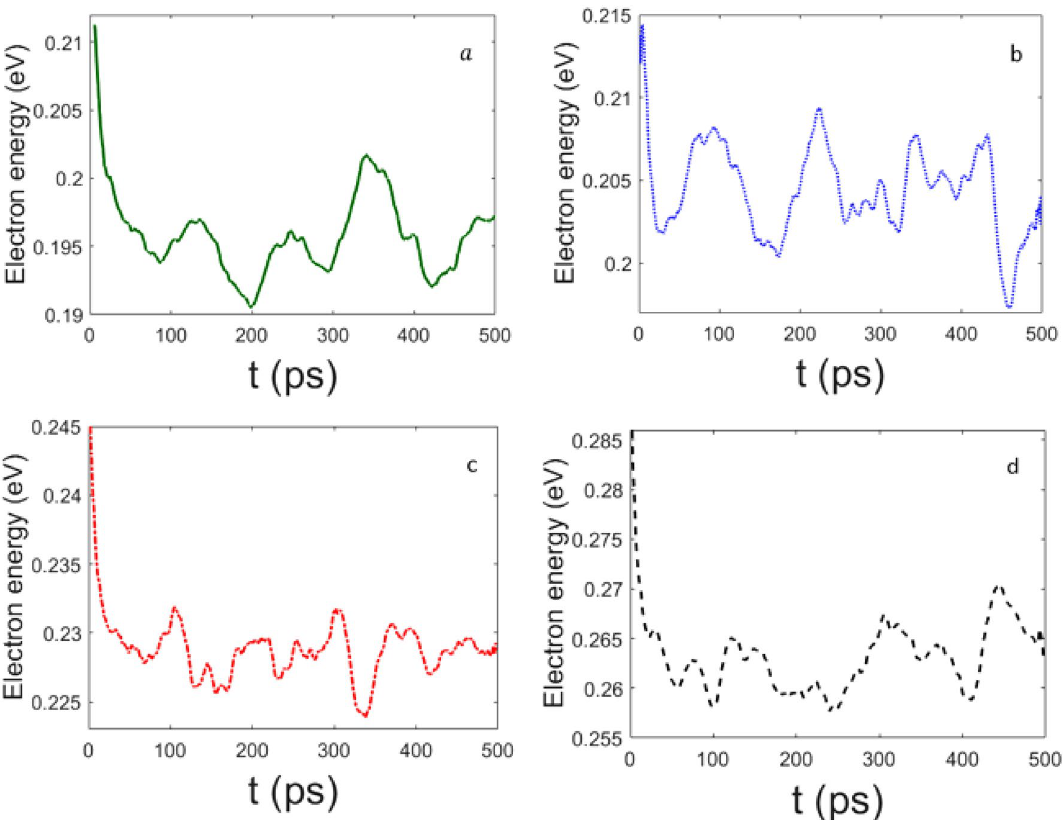
0 , ( b ) ǫ 1 ( ǫ 6.58 meV), ( c ) ǫ ′ = = =